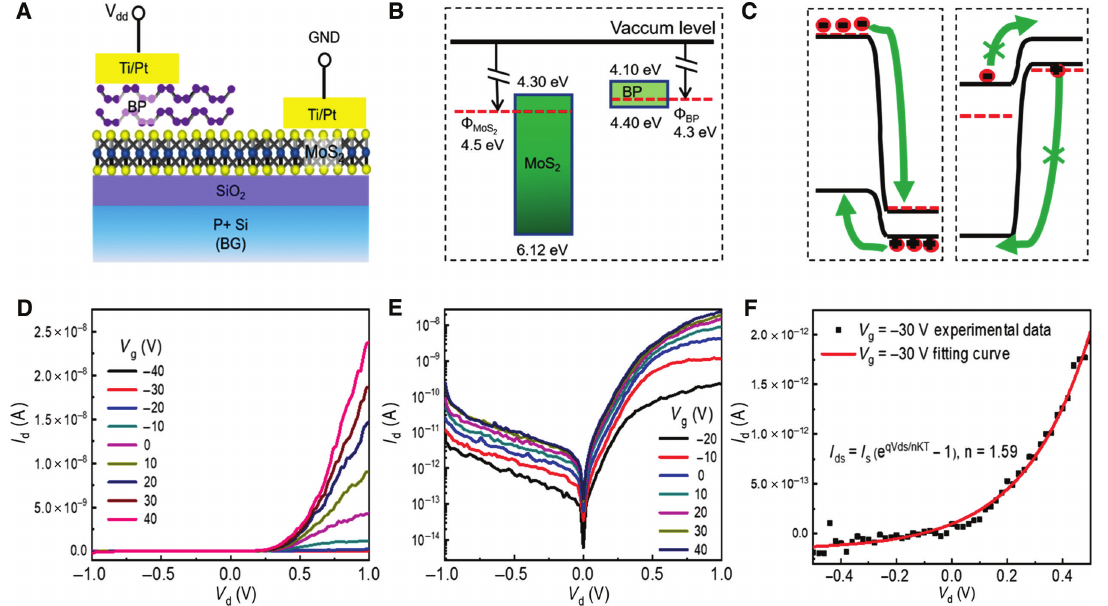
Figure 2: The energy band diagrams and I - V characteristics of the vertical p-n diode. (A) Schematic of the vertical p-n diode structure. (B) Energy band alignment of MoS /BP. (C) Band diagrams explaining the carrier transport 2 in the device under on-state (left) and off-state (right). (D) Gate-tunable I - V characteristics of the device. (E) I - V characteristics in log scale. = −30 V, which is in good agreement with the fitting results of the volt-ampere characteristic (F) I - V characteristic at V g